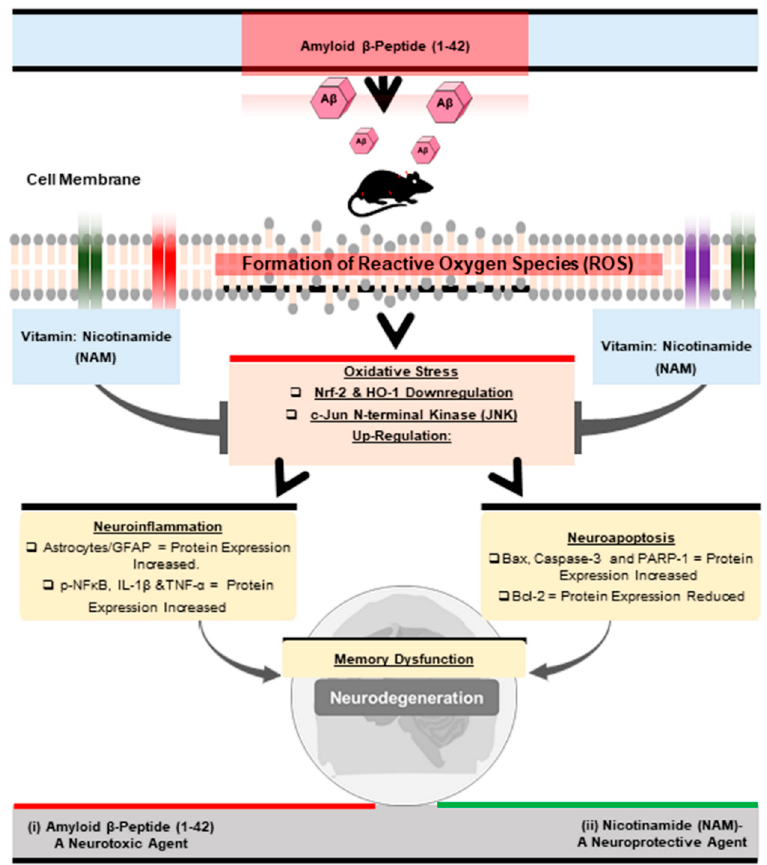
Figure 6. Shows the graphical abstract of the current